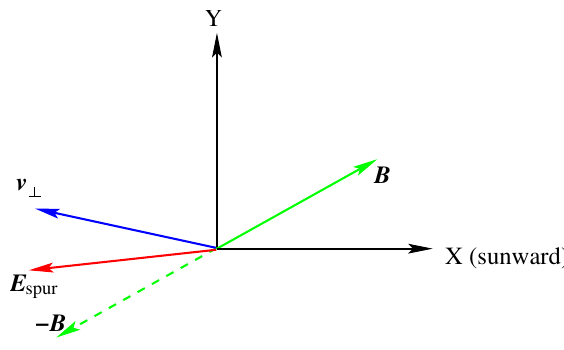
Fig. 10. Directions of various quantities projected onto the spin plane. X and Y are DSI coordinate axes, very close to the GSE axes, so that X is the solar direction which is a reference for the angles in Fig. 9. B is the ambient magnetospheric magnetic field, and E spur is the spurious electric field. The projection of the perpendicular component of the plasma flow is denoted by v ⊥ . The projection in this plane of a 3-D flow velocity v with components perpendicular, as well as antiparallel to the magnetic field, would thus be directed between the v perp and − B vectors, i.e. where we find E spur .